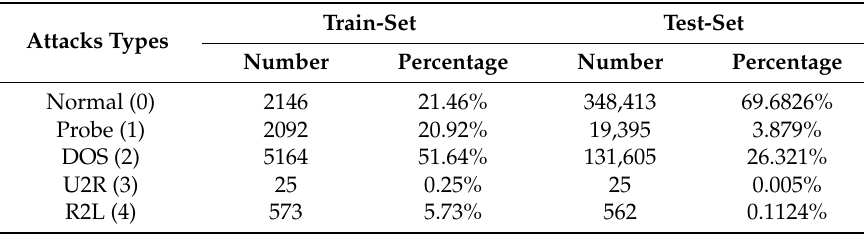
Table 1. The composition of data set.